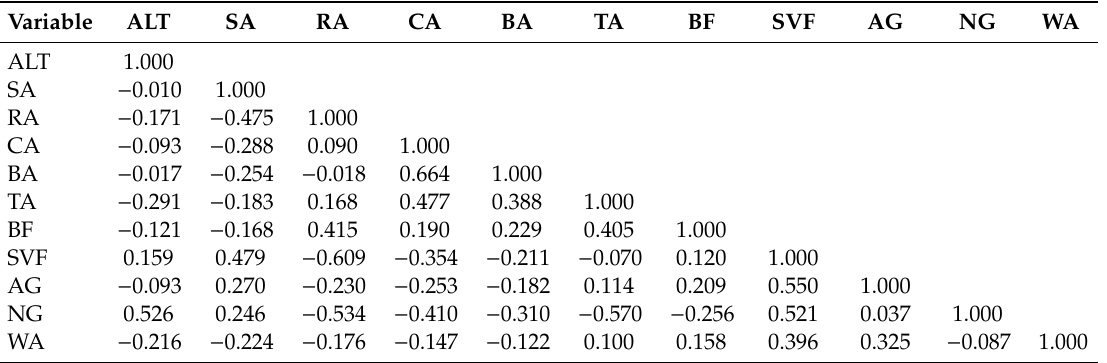
Table 2. Correlation matrix of independent